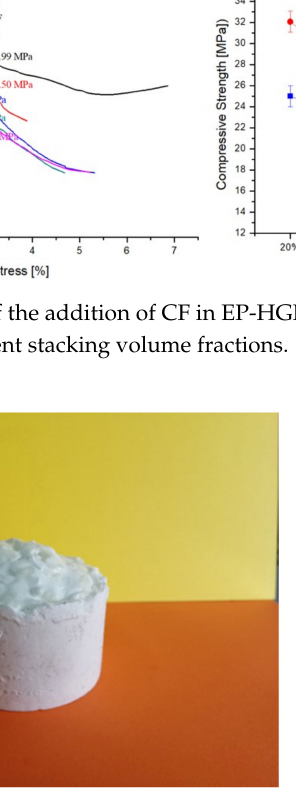
Figure 15. The unshaped ESF.